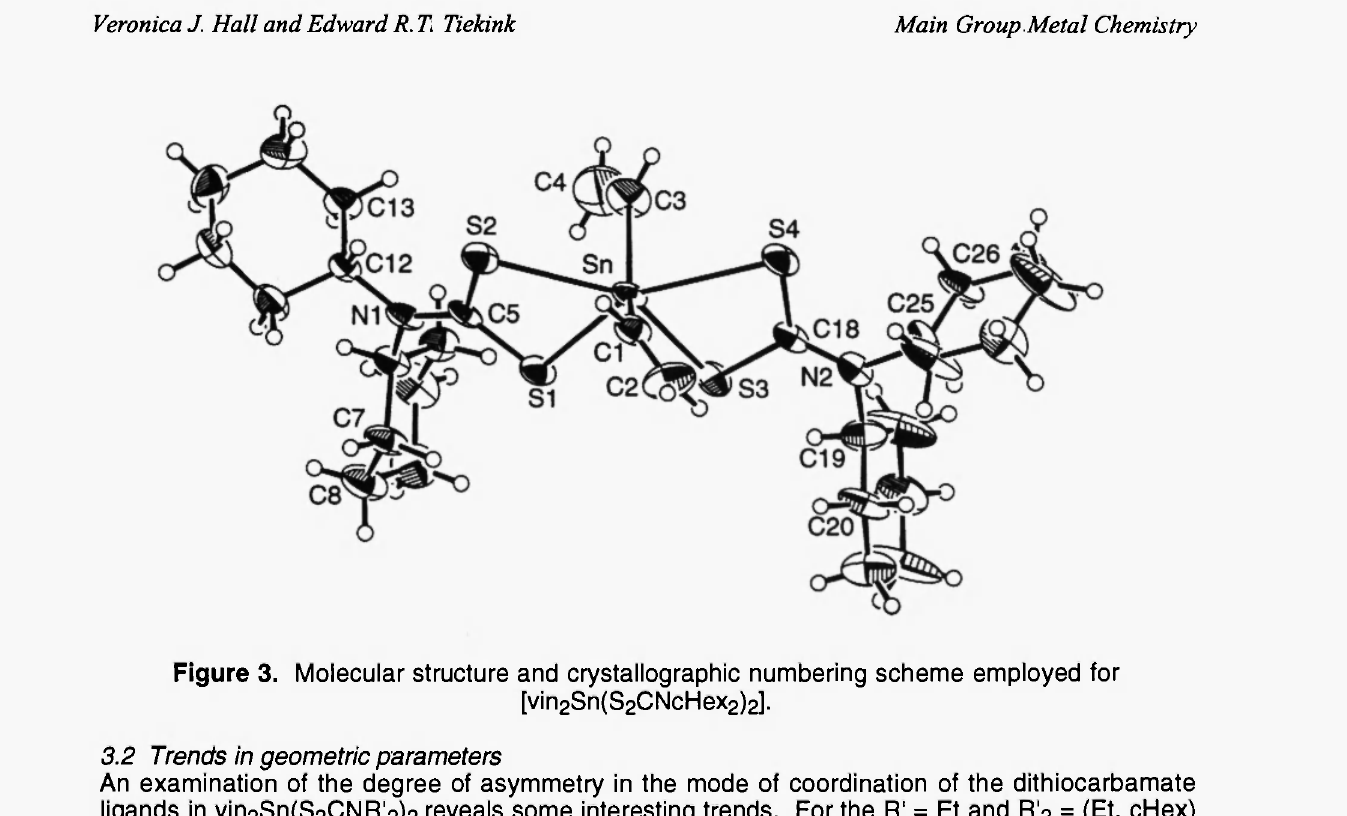
Figure 3. Molecular structure and crystallographic numbering scheme employed for [vin 2 Sn(S 2 CNcHex 2 ) 2 ].